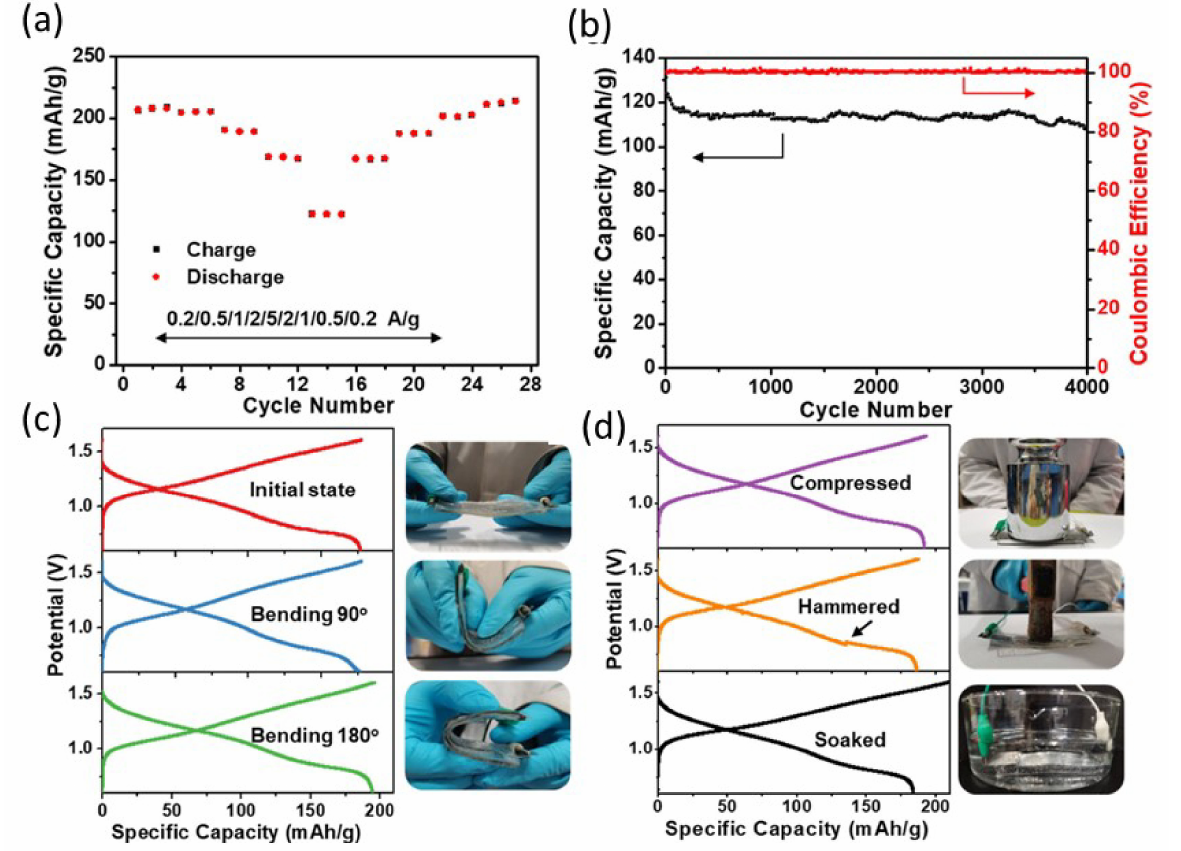
Figure 19. Electrochemical performance of OHE-based Zn||PANI battery at room temperature. ( a ) Cycling performance at various current densities. ( b ) Long-term cycling performance at 5.0 Ag − 1 for 4000 cycles. ( c , d ) Charging and discharging stability of the OHE-based battery under a series of harsh working conditions. Reprinted with permission from Ref. [106]. Copyright 2021 American Chemical